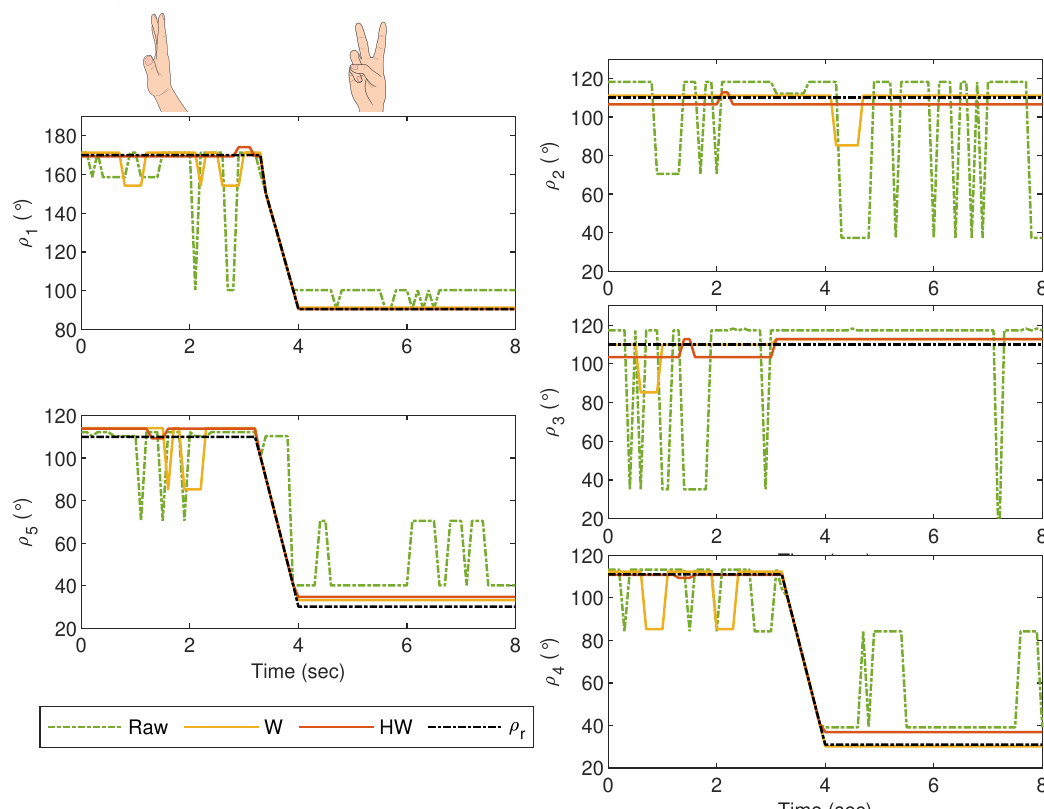
Figure 16. Gesture 2: The mismatch between the glove’s and bionic hand’s goniometry is significantly reduced by using Compensator HW, which also provides a better response as compared to Compensator W, particularly before t = 4 s.